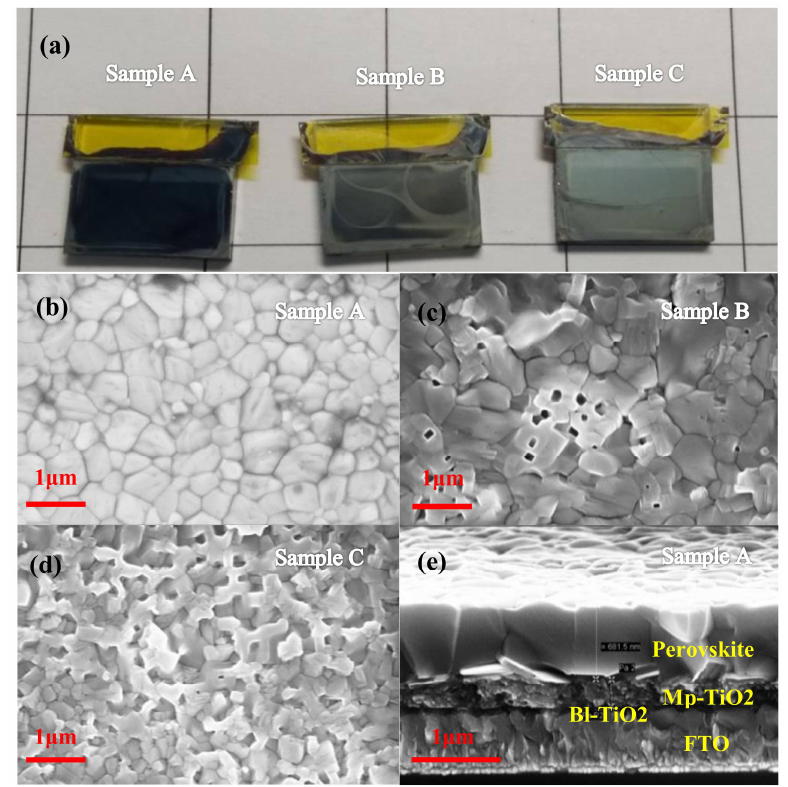
Figure 2. SEM images and picture: ( a ) Surface picture of perovskite films prepared by sequential deposition route with different PbI 2 annealing times (0 s, 10 s and 20 s; corresponding sample A, sample B and sample C); ( b – d ) Surface SEM images of sample A, sample B and sample C; ( e ) Cross-sectional SEM image of sample A.